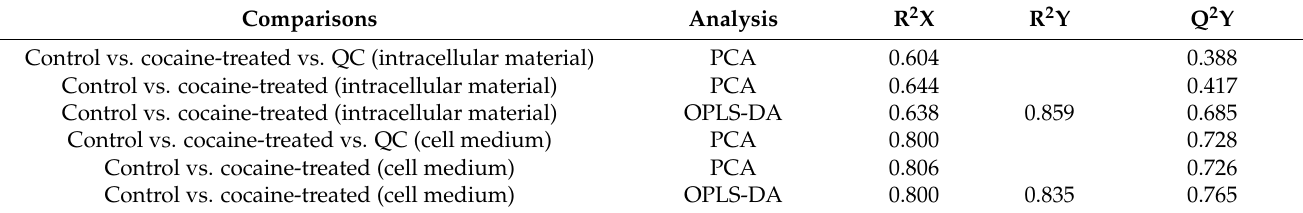
Figure 7. PCA model showing control (blue) vs. cocaine-treated (red) cell medium samples. Table 3. Model characteristics of PCA and OPLS-DA multivariate analysis.